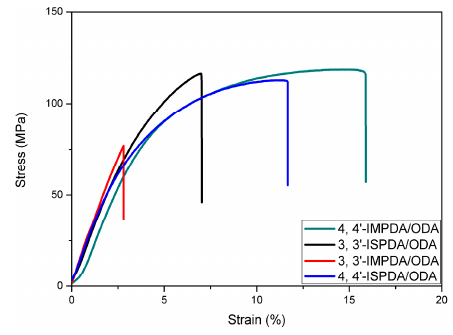
Figure 7. Representative stress-strain curves of isohexides-derived PEIs